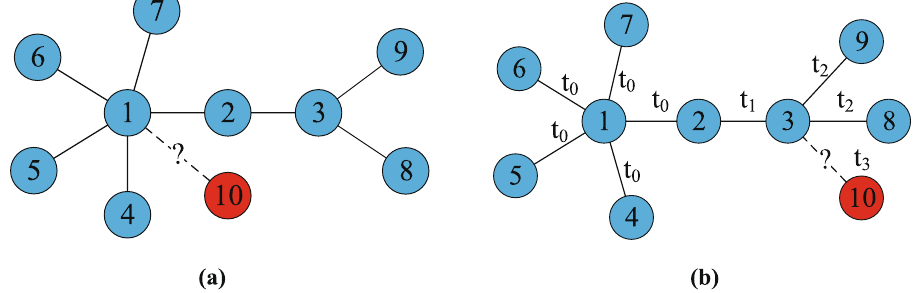
Figure 1. Illustration of the popularity. The fresh link and node 10 will be added into the existing networks at the next time t 3 . In panel (a), attractiveness of nodes are determined by static features. According to the preferential attachment, node 10 prefers to connect with node 1 due to the largest degree. In panel (b), temporal effects are considered. The currently popular node 3 may become attractive and connect with node 10 at time t 3